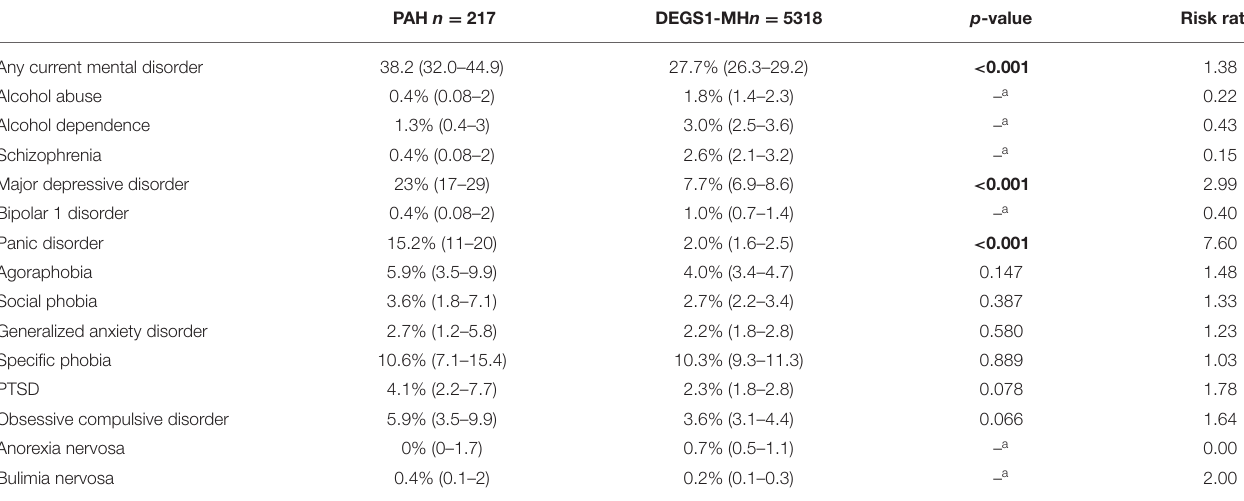
TABLE 2 | Prevalence of common mental disorders of PAH in comparison with data from the general German population (DEGS1-MH).